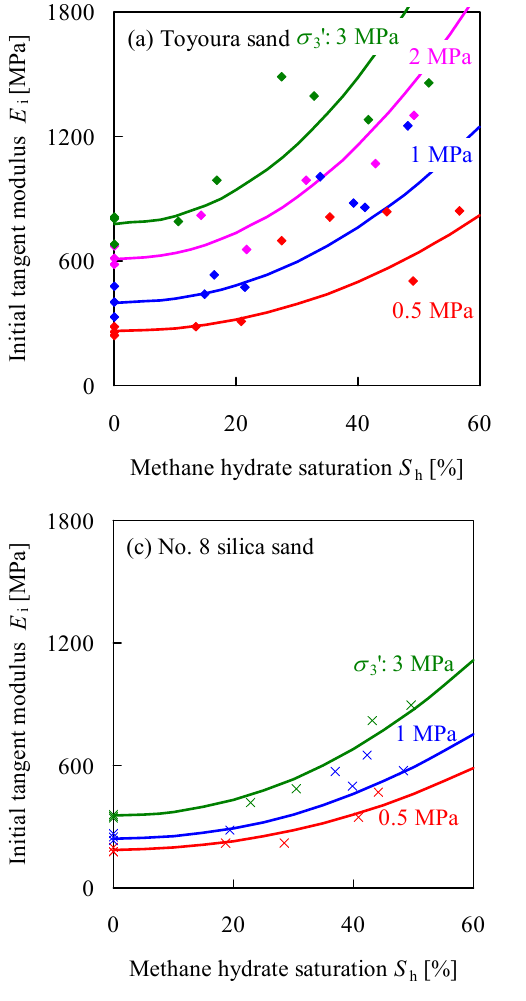
for specimens h